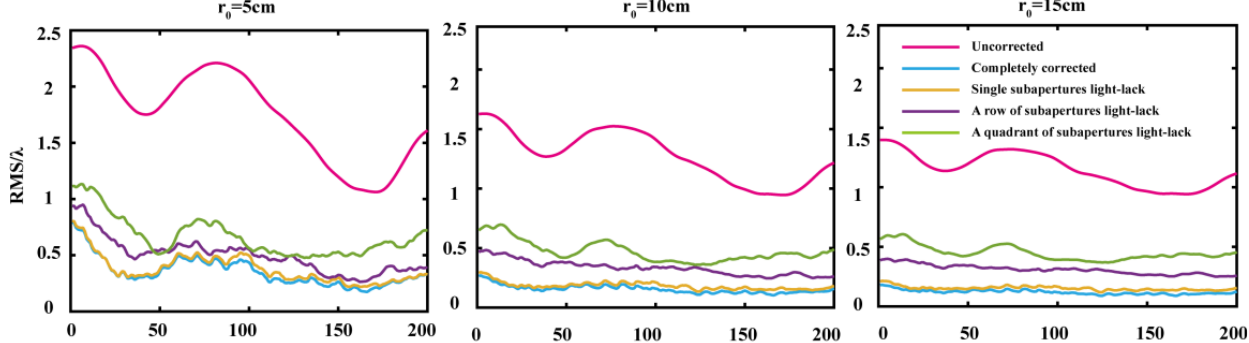
Figure 12. Correction results of 200 frames under different situations of under-sampling, for r 0 are 5 cm, 10 cm, and 15 cm, respectively. The pinkish red line represents the uncorrected aberrant wavefront distorted by the turbulence, the blue line represents the turbulence was corrected with all the sub-apertures were illuminate, the yellow line represents a single sub-aperture lack of light, the purple line represents a row of sub-apertures lack of light, the green line represents a quadrant of sub-apertures lack of light.